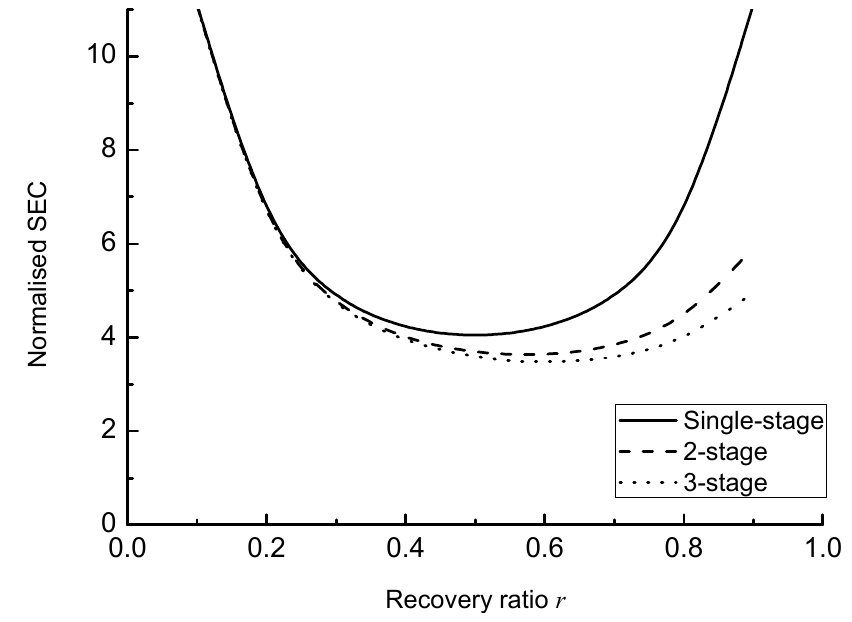
Figure 12. Theoretical limit of normalized SEC in staged ROs without ERD.